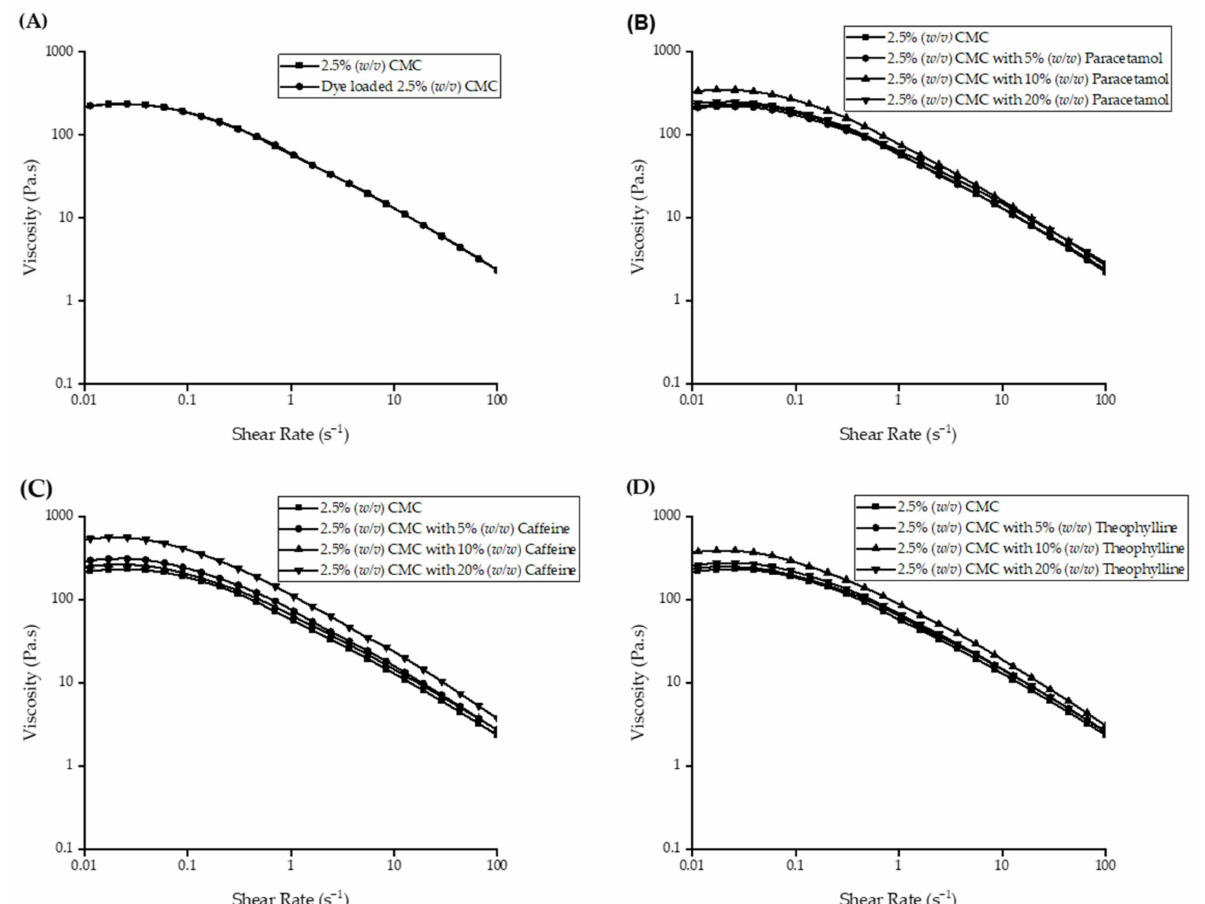
Figure 3. Rheological profiles of both ( A ) dye-loaded and ( B–D ) API-loaded 2.5 w/v % CMC